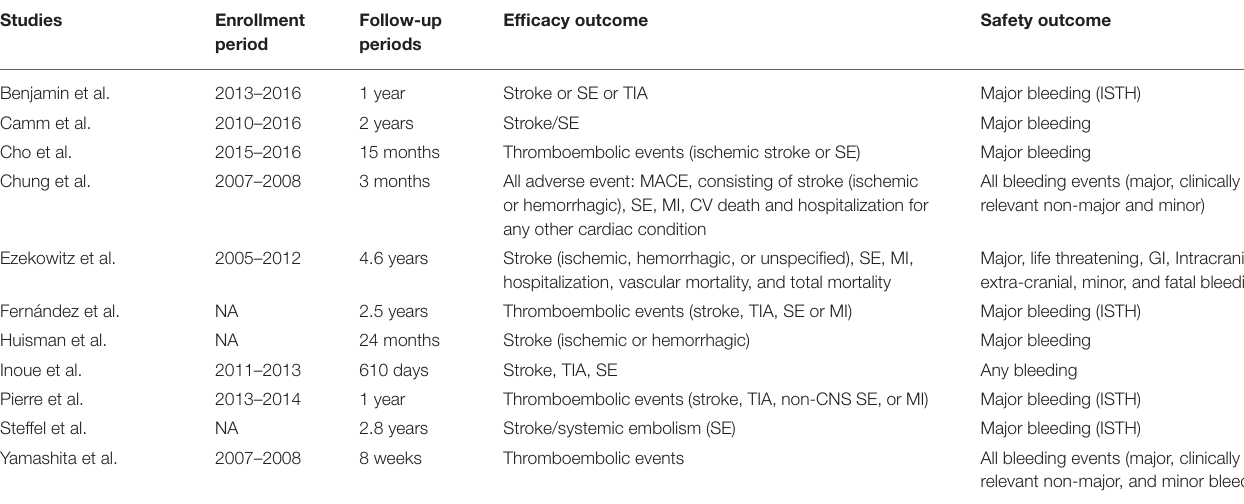
TABLE 3 | Follow up periods and reported